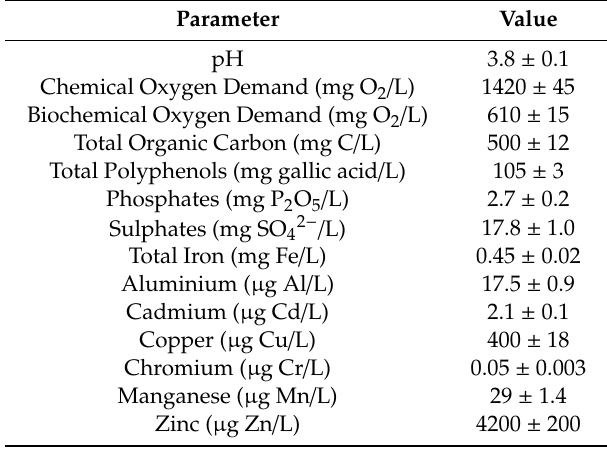
Table 1. Agro-industrial wastewater